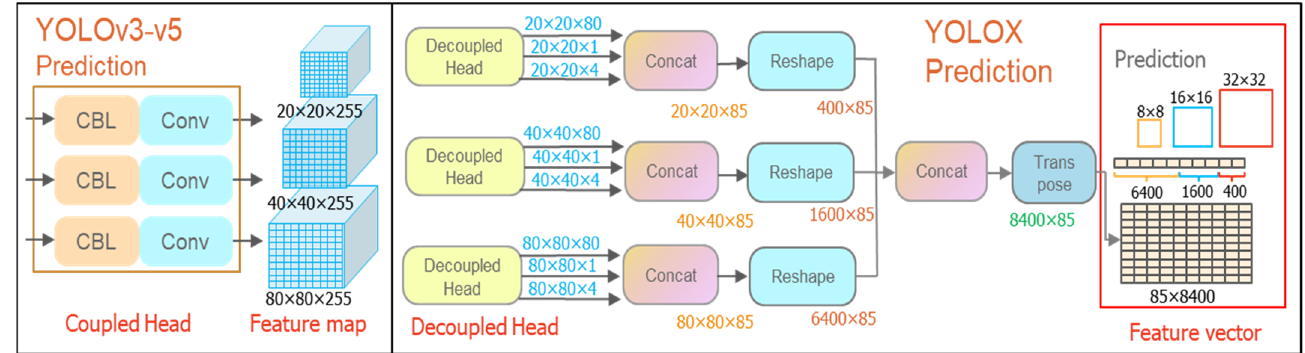
Figure 7. YOLO series detection head structure. The CBL module consists of Convolution, Batch Normalization, and LeakyRelu functions ( x , x > 0; a × x , x ≤ 0 ) to extract and transform the input features, where a is a tiny constant. The number of prediction boxes corresponding to the three types of feature points is 6400, 1600, and 400,